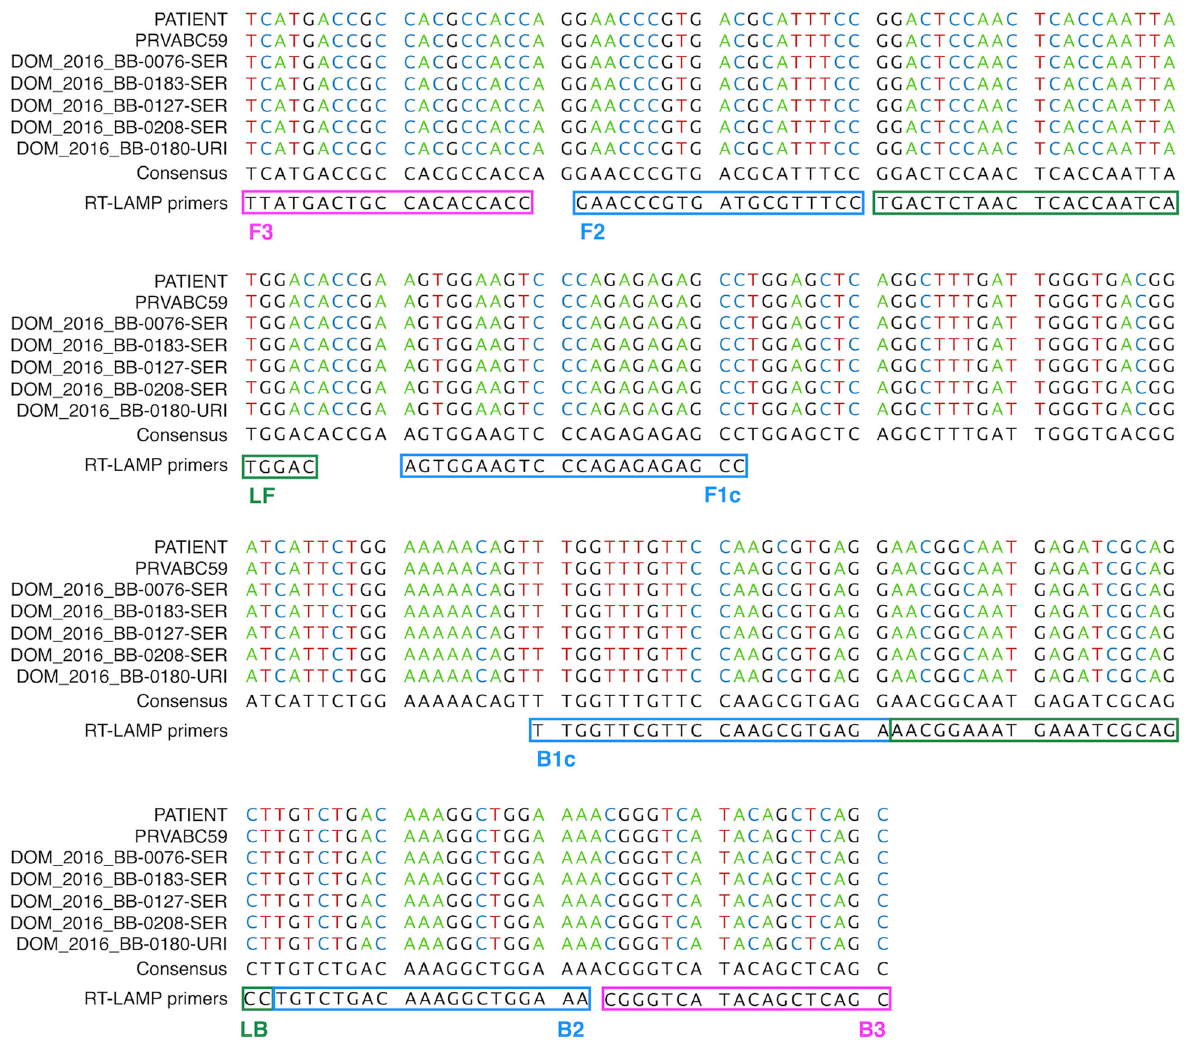
Fig. 5 Multiple sequence alignment of ZIKV PATIENT with PR and previously reported ZIKV isolated in the Dominican Republic. RT-LAMP primers, which are specific for MR, are indicated by